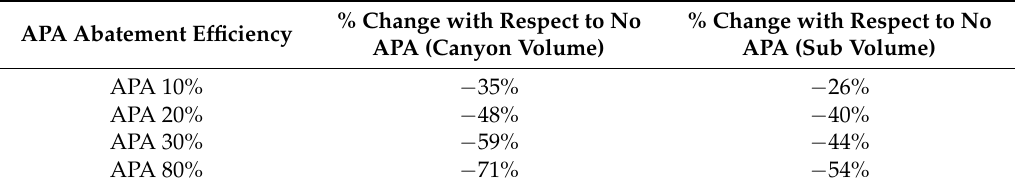
Table 1. Percent change of passive tracer average concentration in the entire volume of the canyon and in a sub-volume at human height with respect to the reference case without the scrubber for H/W = 3. Different APA abatement efficiencies are analyzed. Simulated values are relative to concentrations after 2000 s.